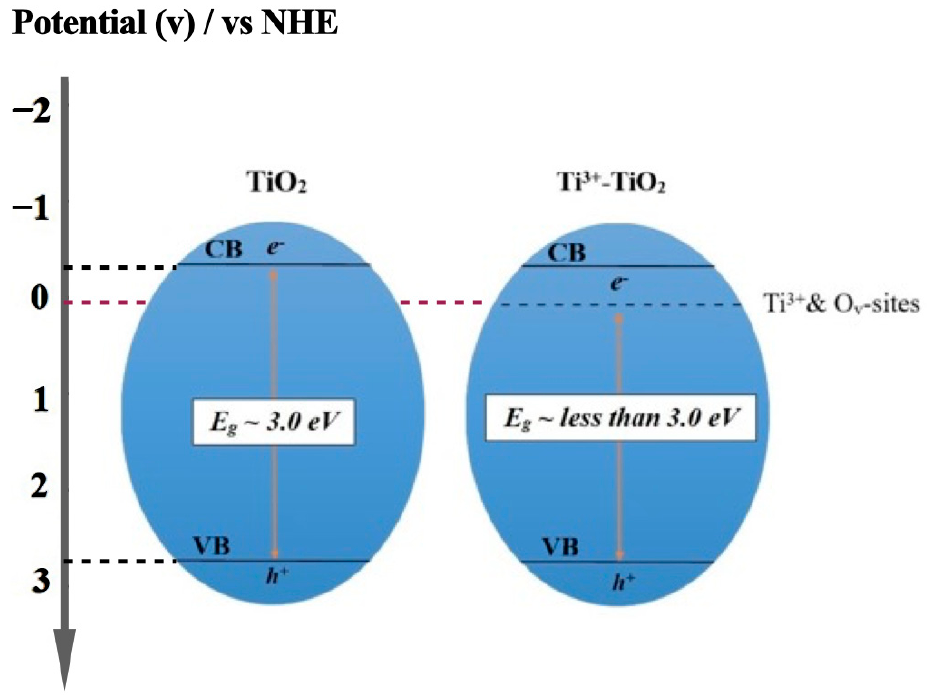
Figure 1. Schematic showing energy levels of TiO 2 in the presence of Ti 3+ ions.